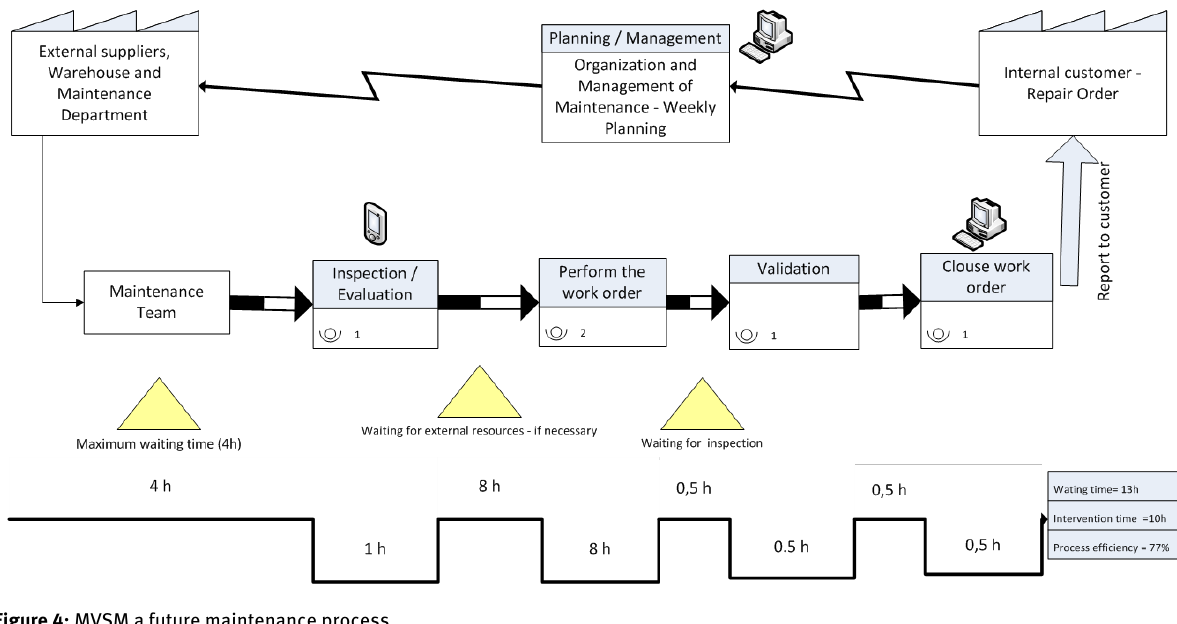
Figure 4: MVSM a future maintenance process.